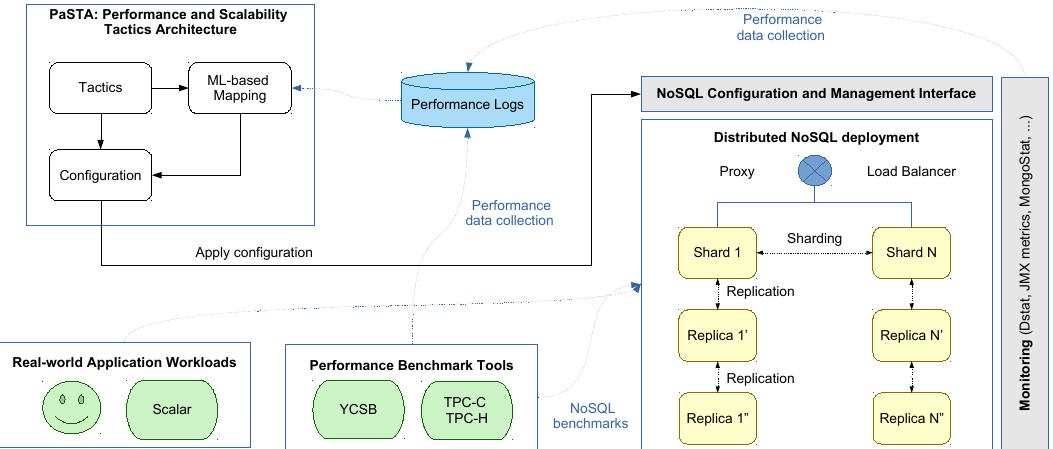
Figure 5. Machine learning based mapping of performance and scalability tactics through runtime configuration on NoSQL